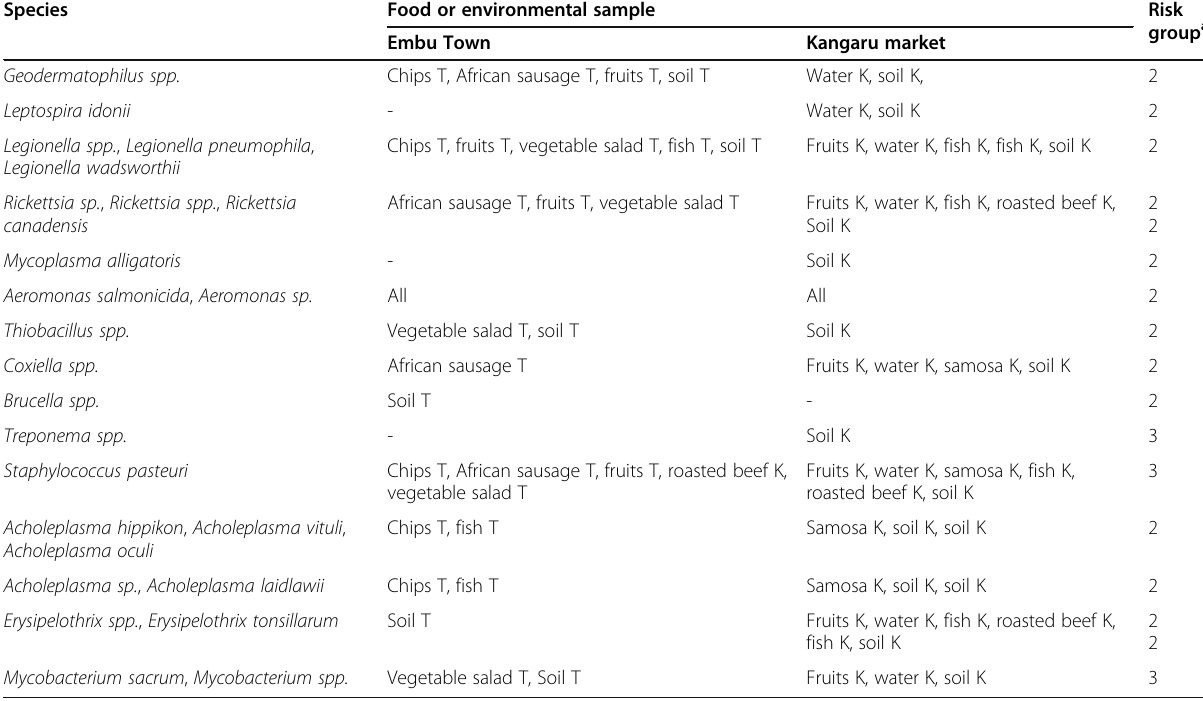
Table 2 Potentially pathogenic bacteria detected in food and environmental samples from Embu Town and Kangaru Market Species Food or environmental sample Geodermatophilus spp.